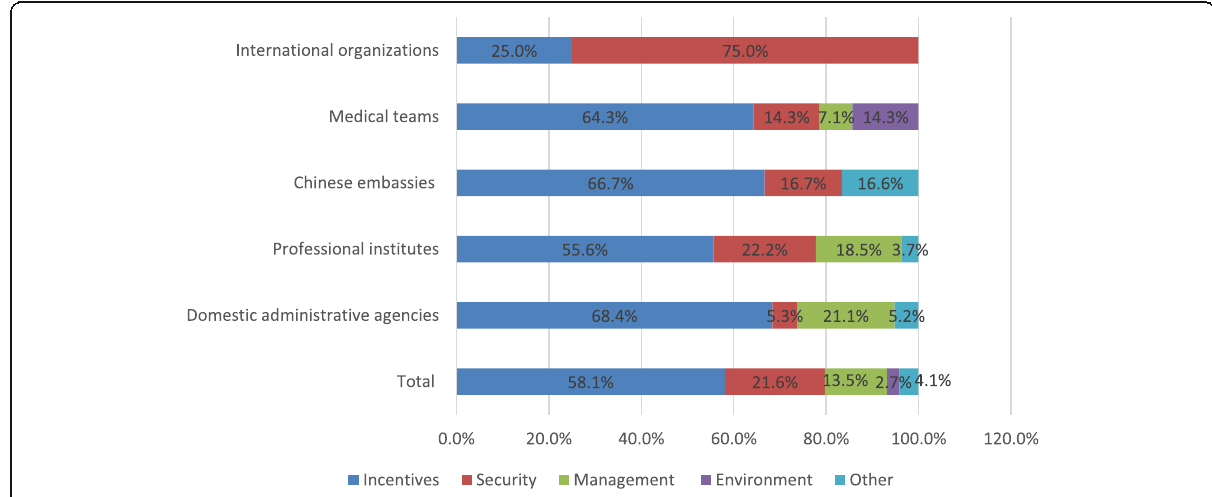
Fig. 2 Factors influencing the deployment of the Chinese global health workforce according to five different